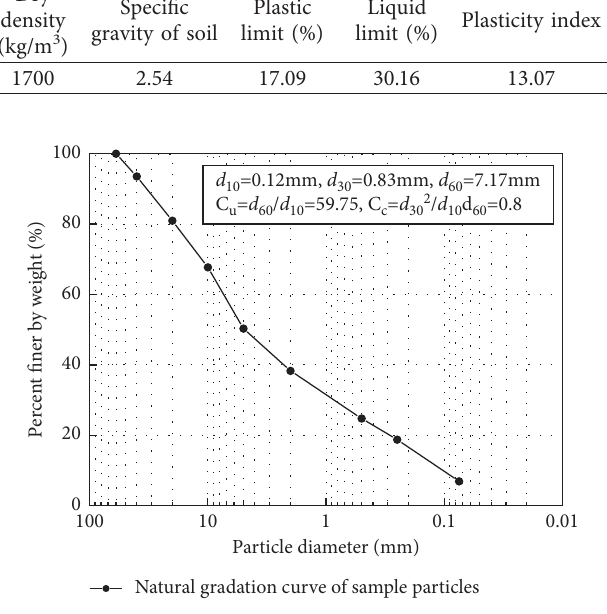
Figure 1: Grading curve of the sample.